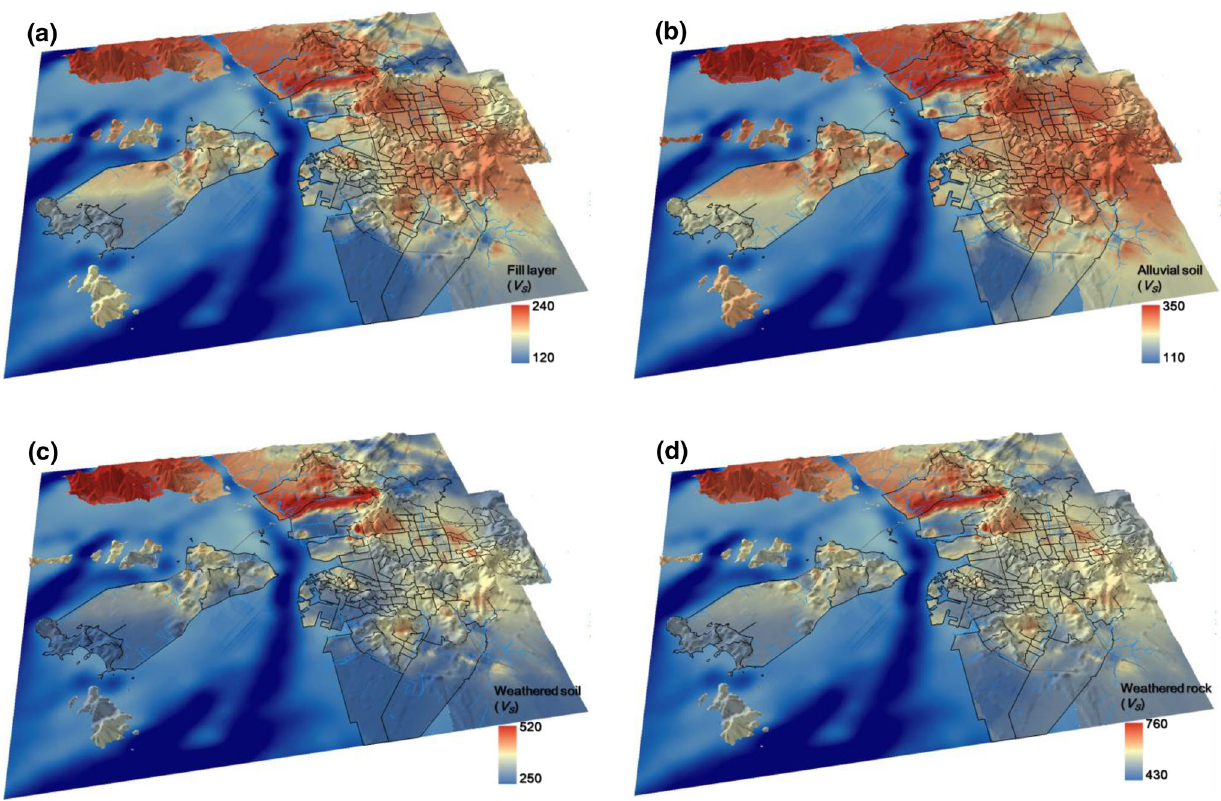
Fig. 8 The Incheon and Bucheon study areas in South Korea: Geotechnical spatial grid information of average V S for each geo-layer in the Incheon and Bucheon areas: a fill; b alluvial soil; c weathered soil; d weathered